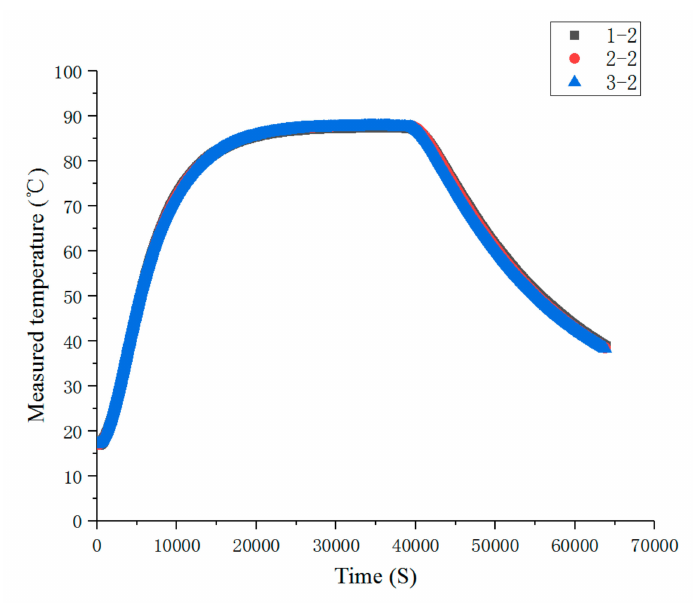
Figure 17. Comparison of the transient temperature measurements at the second measuring point of each temperature